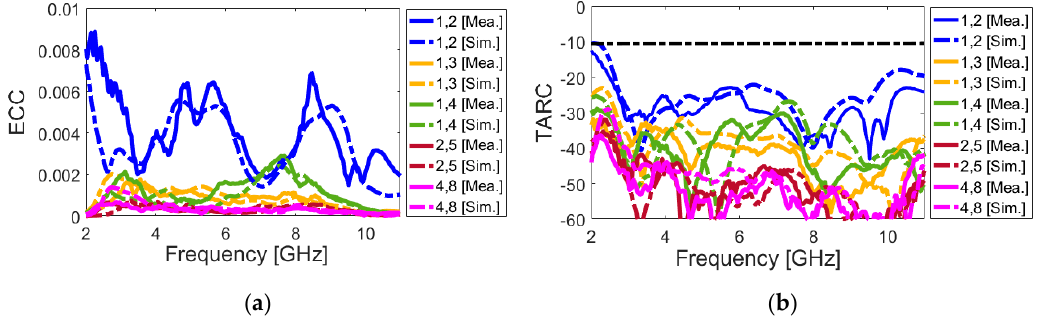
Figure 22. Measured (dash line ) and simulated (solid line) radiation pattern results for Ant. 1 and